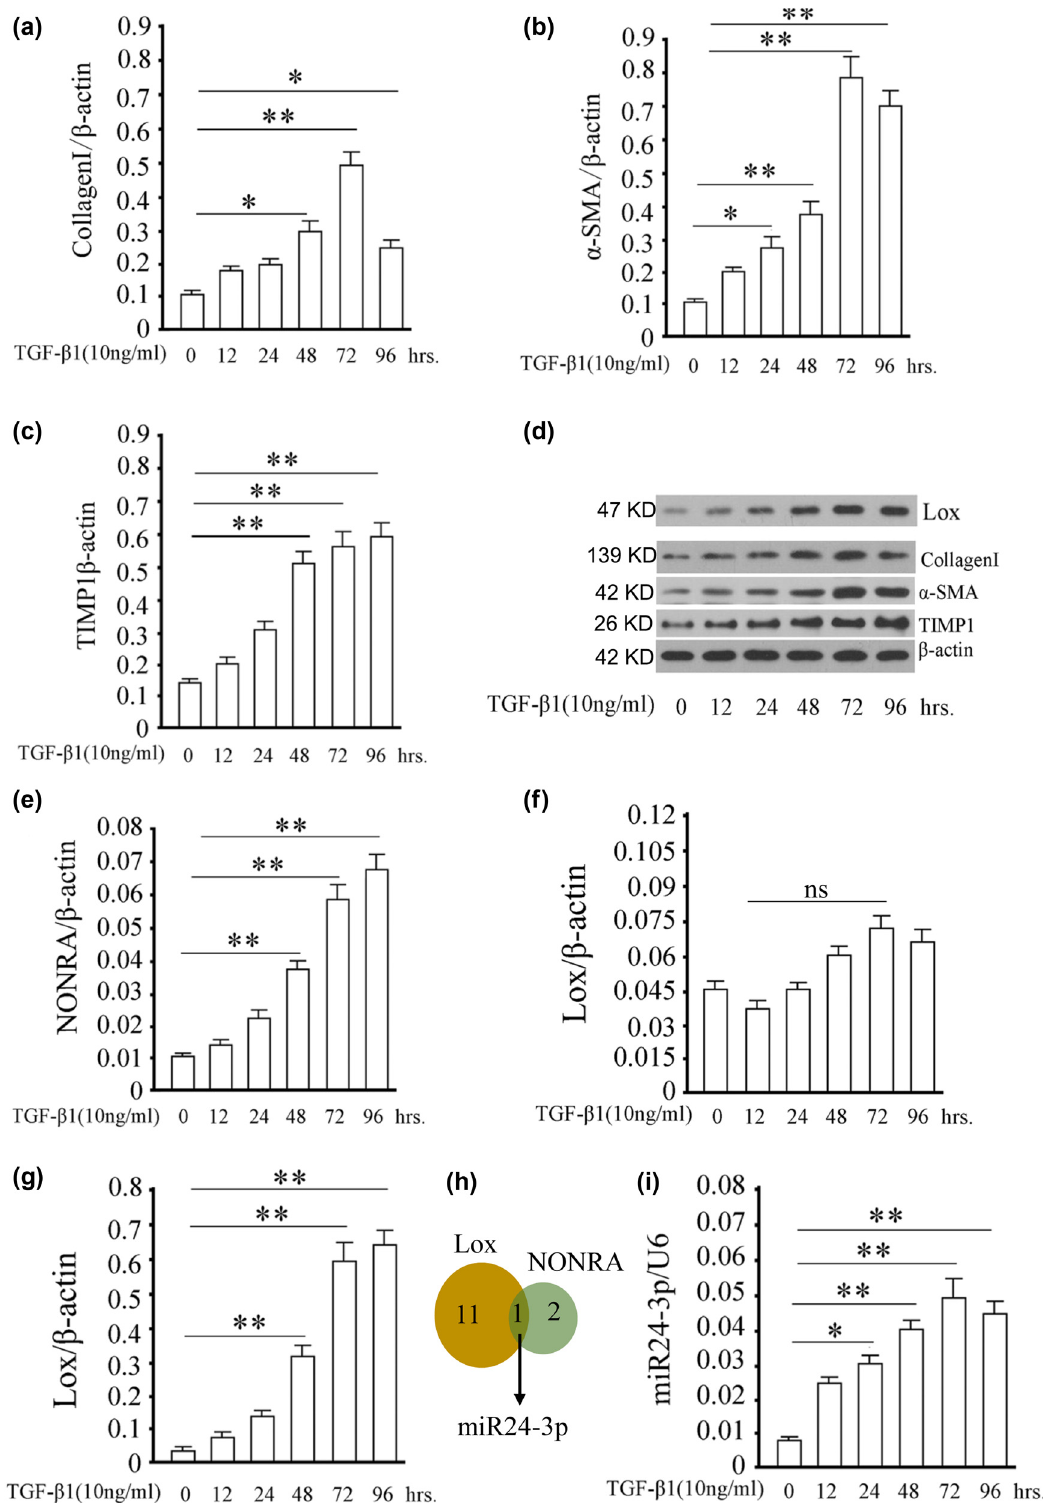
Figure 1: Activation of HSCs induced by TGF - β 1. HSCs were induced by 10 ng/mL TGF - β 1 for 0 – 96 h, and HSCs at di ff erent time points were collected to extract total protein. The gray statistics of western blotting of HSCs activation markers of collagen I ( a ) , α - SMA ( b ) , and TIMP1 ( c ) . ( d ) Gel image of collagen I, α - SMA, TIMP1, and Lox of western blotting. ( e ) Relative expression of NONRATT013819.2 using RT - qPCR. ( f ) Relative expression of lox using RT - qPCR. ( g ) The gray statistics of western blotting of lox in HSCs. ( h ) Venn diagram of miRNAs targeted by lox and NONRATT013819.2, only miR24 - 3p is shared by both. ( i ) Relative expression of miR24 - 3p using RT - qPCR. * P < 0.05, * P < 0.01 vs control group ( 0 h induction group )